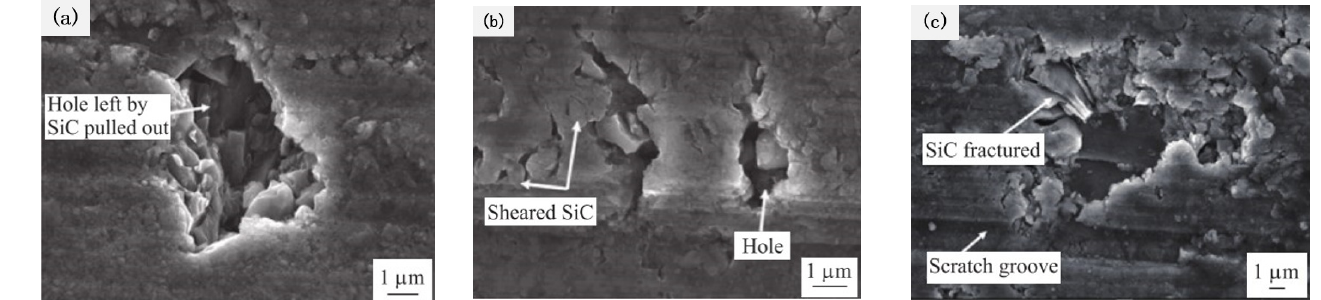
Figure 8. Surface morphology of milling SiCp/Al composites. ( a ). Hole left by SiC pulled out ( b ). Sheared SiC and Hole ( c ). SiC fractured and Scratch groove